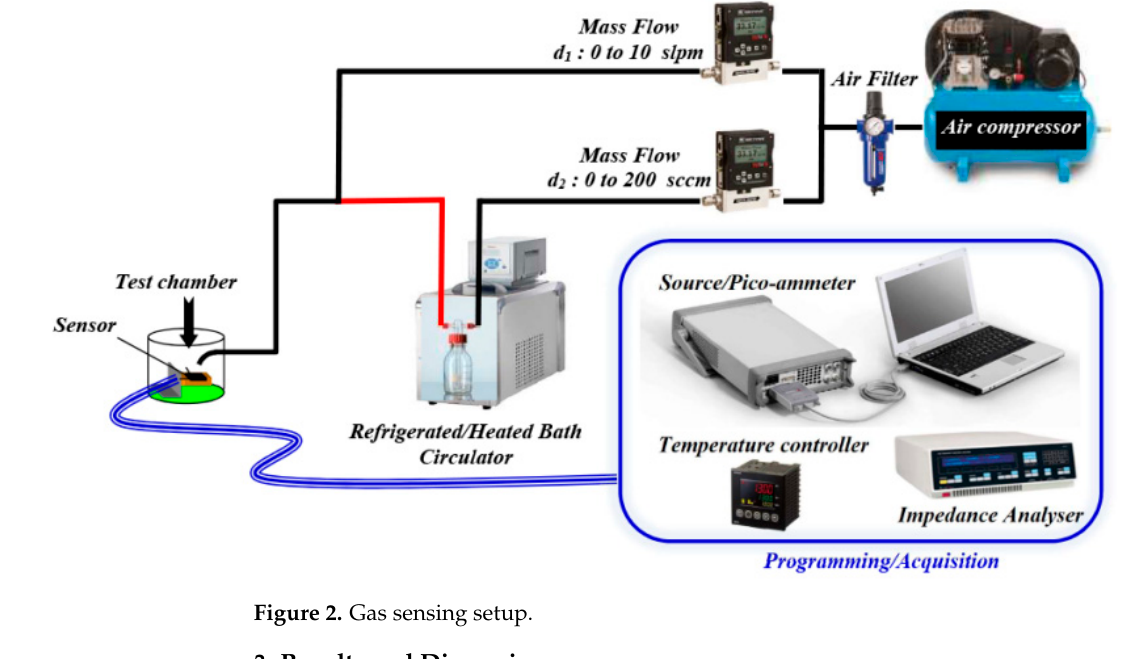
Figure 2. Gas sensing setup.